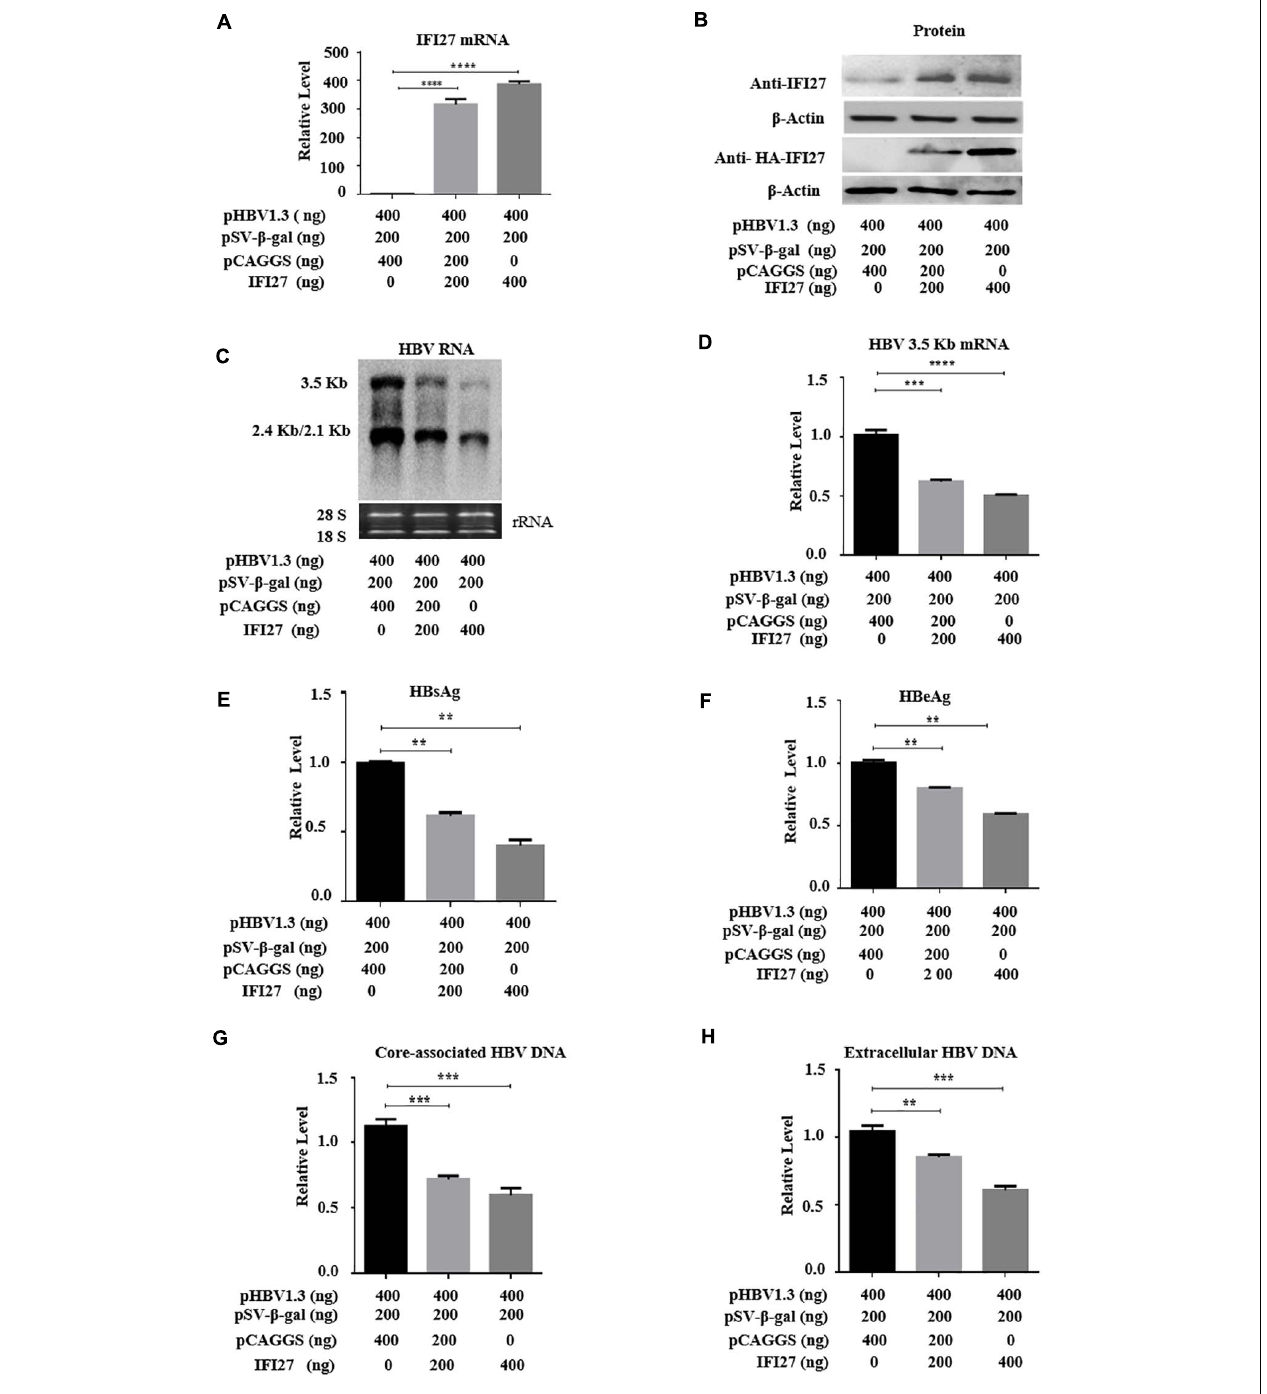
FIGURE 2 | Overexpression of IFI27 inhibits HBV gene expression in HepG2 cells. (A–F) Human hepatoma cells (HepG2) were co-transfected with pHBV1.3 plasmid, pSV- β -gal, and pCAGGS-HA-IFI27 or pCAGGS (empty vector) at different concentrations for 48 h, as indicated in the artwork. (A) The IFI27 mRNA expression was detected by qRT-PCR. GAPDH was used as an internal control. (B) The expression levels of IFI27 protein were determined by western blotting using anti-IFI27 and anti-HA antibodies, respectively. β -Actin expression was used as a loading control. (C) The total HBV RNA was extracted and subjected to northern blot analysis. The rRNAs (28S and 18S) were used as the internal control. (D) Intercellular HBV 3.2 kb mRNA was detected by qRT-PCR. GAPDH mRNA expression was used to normalized the data. (E,F) Secreted HBsAg (E) and HBeAg (F) in the supernatants were determined by using ELISA. (G,H) HepG2 cells were transfected with pHBV1.3 plasmid vector together with pCAGGS-IFI27 or pCAGGS (empty vector) in a dose-dependent manner for 96 h. (G) The HBV intracellular core-associated and extracellular HBV DNA (H) from the supernatant were extracted and measured by qPCR. ** P ≤ 0.01, *** P ≤ 0.001, **** P ≤ 0.0001.